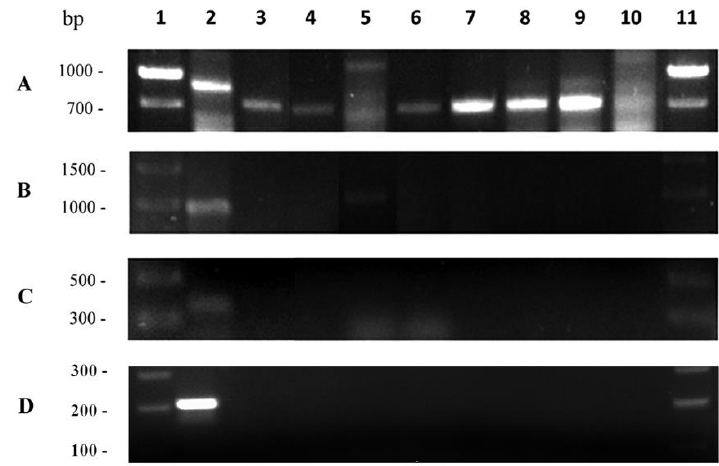
Figure 2. Presence of ( A ) tdc , ( B ) odc, ( C ) hdc , and ( D ) pdc genes in LAB strains. Lanes: 1, kb ladder (Bioron); 2, positive control ( Lactobacillus brevis CECT 5354 for the tdc and pdc genes, L. rhamnosus CECT 288 for the odc gene and L. helveticus CECT 403 for the hdc gene); 3, UVI-14; 4, UVI-20; 5, UVI-5; 6, UVI-17; 7, UVI-18; 8, UVI-21; 9, UVI-23; 10, UVI-2.